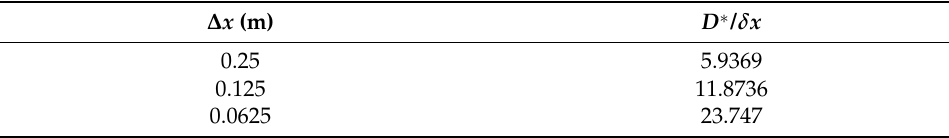
Table 2. Proposed mesh sizes and their respective